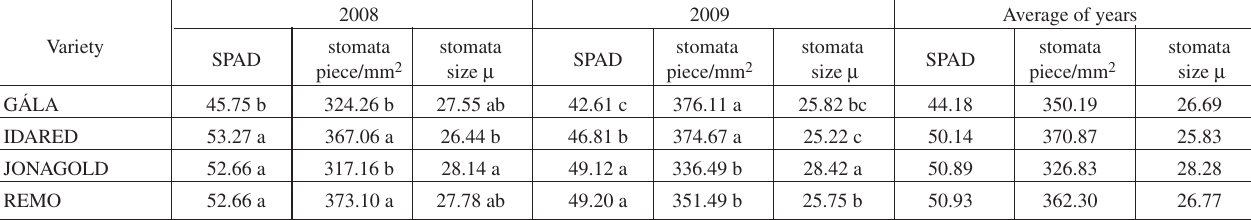
Table 4. Relative chlorophyll content (SPAD) and stomata density on the leaves of apple varieties grown by integrated